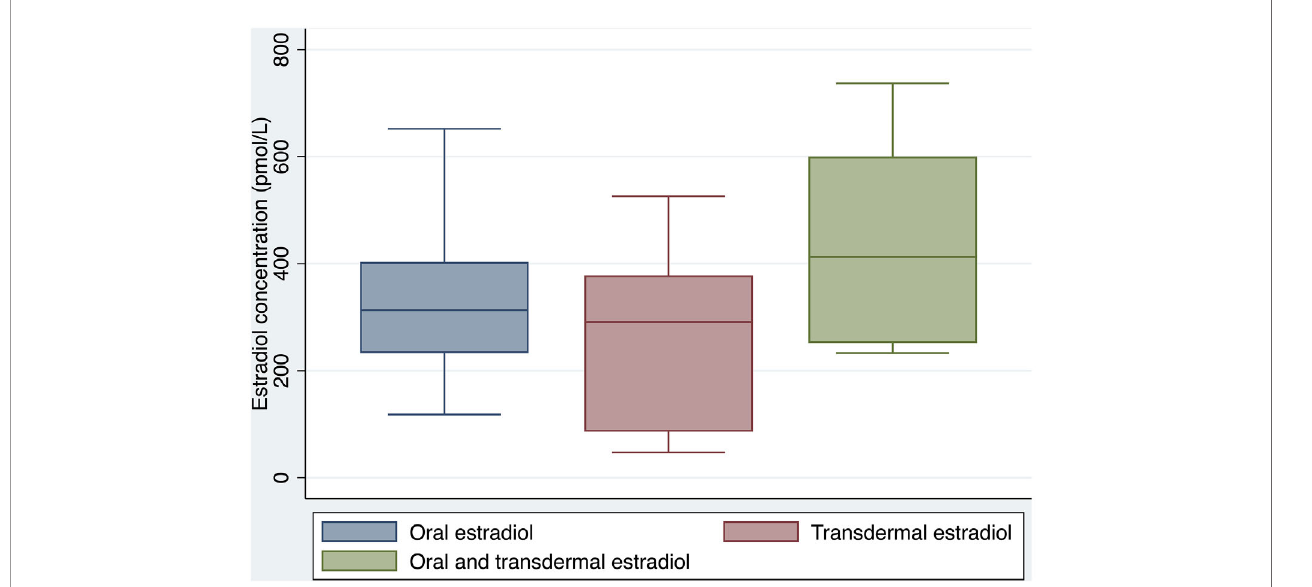
FIGURE 1 | Serum estradiol concentration by estradiol formulation (age ≥ 45 years).